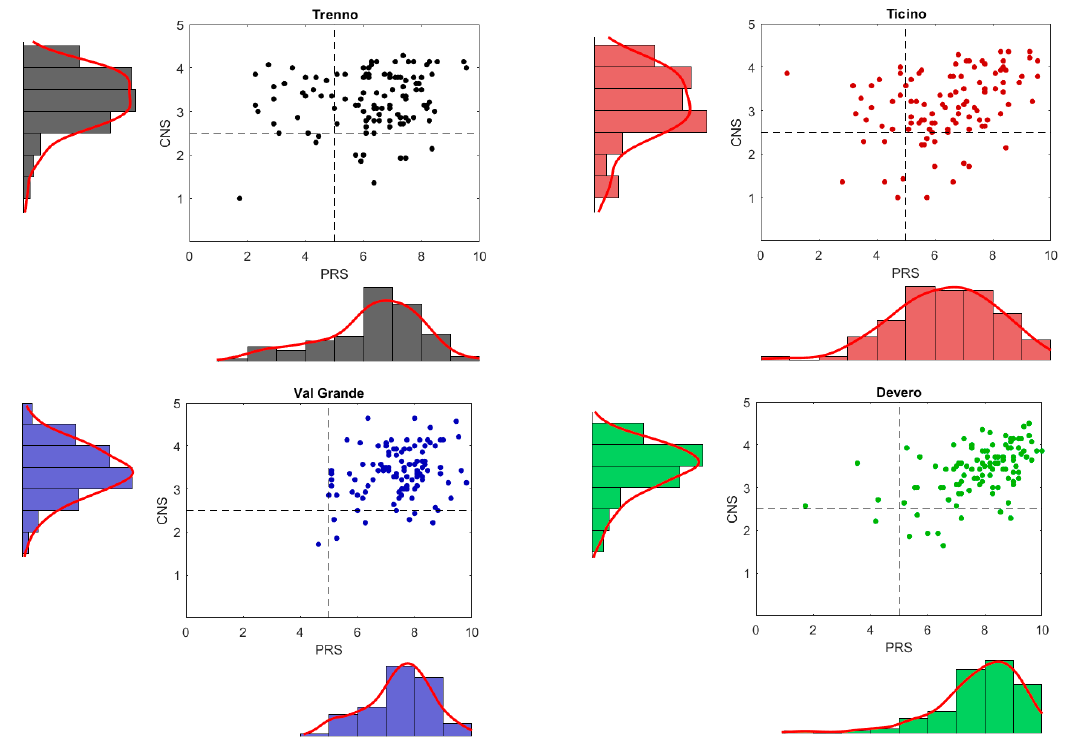
Figure 4. Four scatter plots, one for each setting: the x-axis represents the PRS and the y-axis represents the CNS; each axis is associated with the corresponding distribution through a histogram and a probability density function. The CNS distribution is approximately the same for all settings, while the PRS distribution lowers to the left only for low BQ settings.